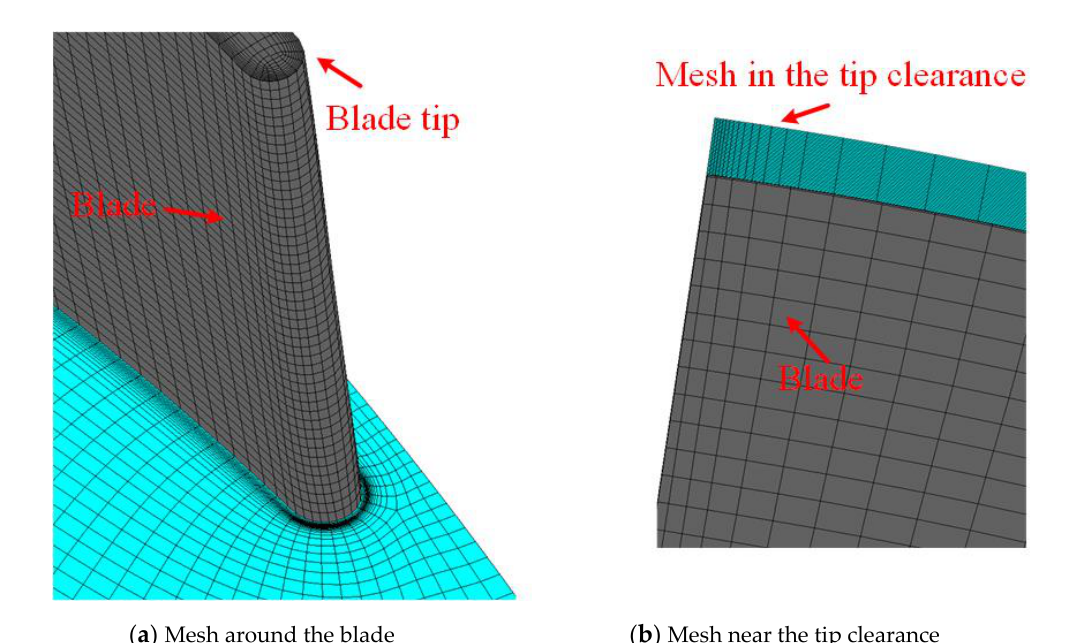
Figure 4. Computational domain mesh.